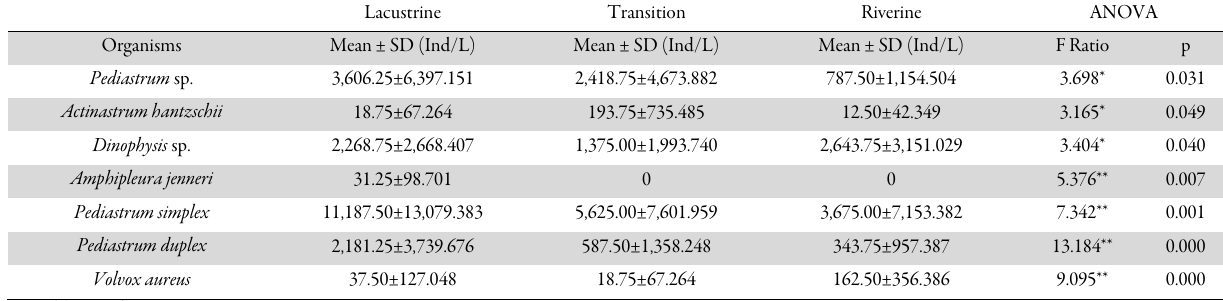
Table 3. ANOVA statistics showing significant spatial variations in phytoplankton species abundance